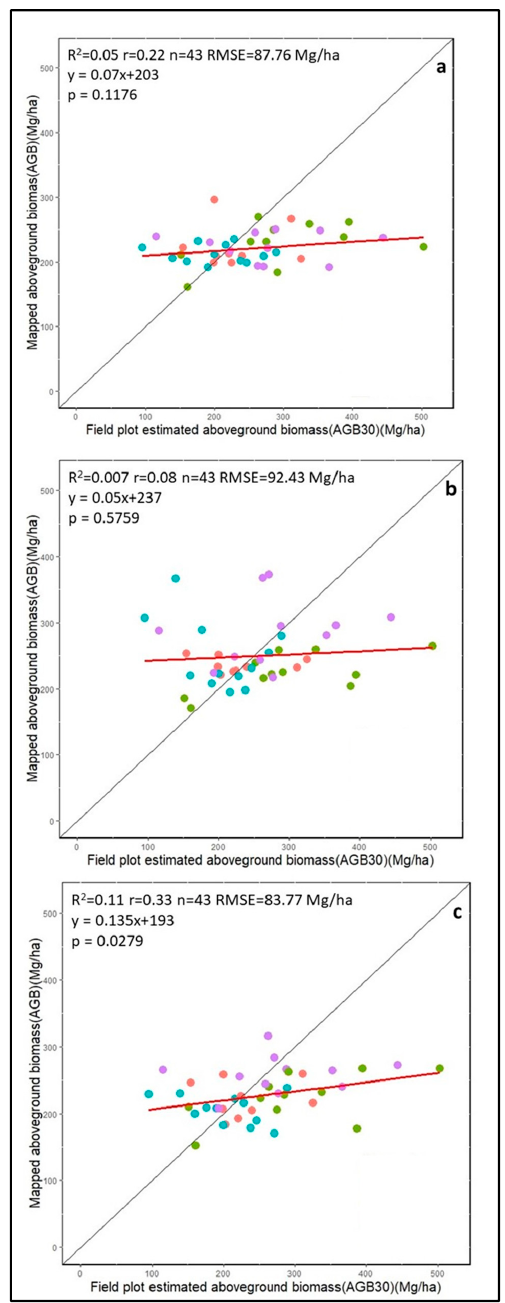
Figure 7. Scatterplots comparing the area weighted field plot above ground biomass (AGB 30 ) (Equation (3)) with the corresponding 30 m aboveground biomass (Figure 6) derived from the 30 m predicted dominant forest canopy height maps generated using ( a ) the dry season July 14th 2013 Landsat-8 OLI image, ( b ) the wet season December 8th 2014 Landsat-8 OLI image, and ( c ) both images. The dots are color coded by which one-hectare field plot the AGB 30 were derived from.